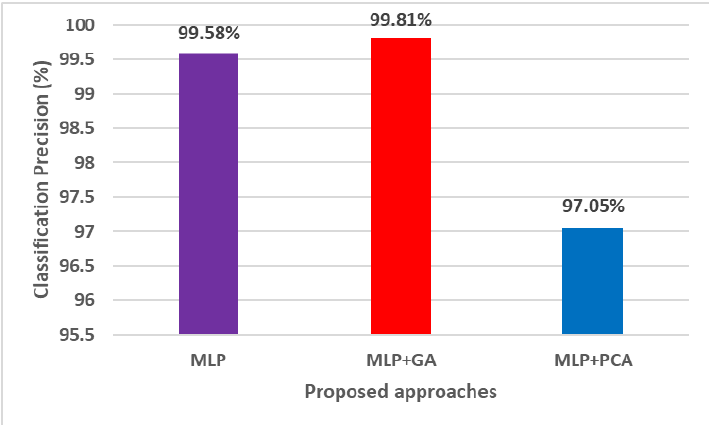
Figure 5. Comparative results of the RFI classification results with considering BS = 1 and HLN = 30 MLP (with all features), MLP + GA ( NoF = 5) and MLP + PCA ( NoF = 5).